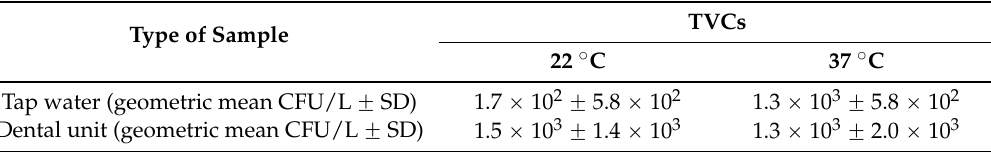
Table 3. Quantitative results obtained using TVCs.